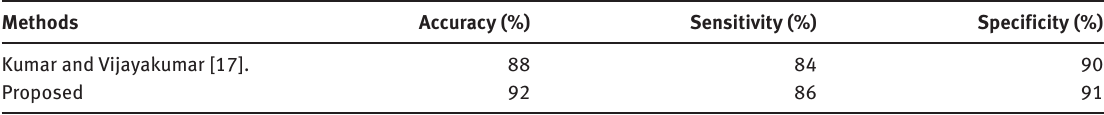
Table 4: Comparative Analysis. Methods Accuracy (%) Sensitivity (%) Specificity (%) Kumar and Vijayakumar [17]. 88 84 90 Proposed 92 86